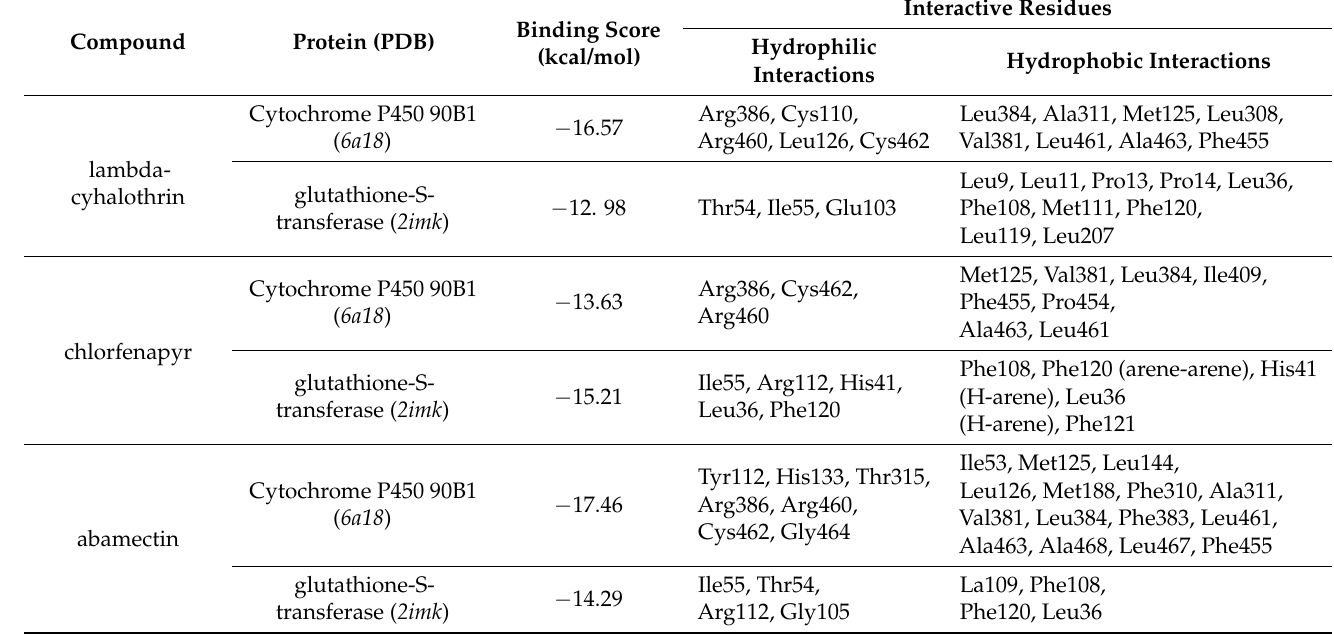
Table 3. Interactions and binding scores of the pesticides chlorfenapyr, abamectin, and